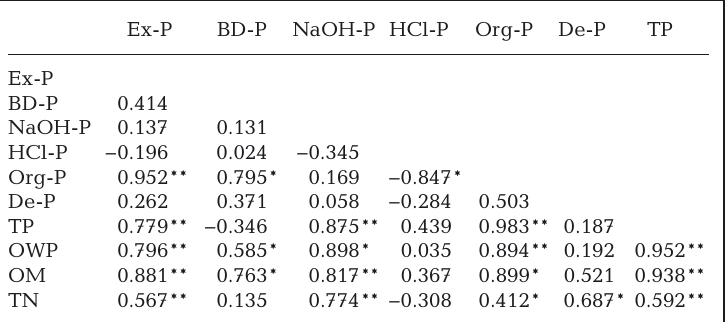
Table 3. Pearson correlation coefficients between the concentrations of different phosphorus (P) fractions, overlying-water phosphate (OWP), or- ganic matter (OM), and total nitrogen (TN). BD-P: redox-sensitive P; De-P: detrital P; Ex-P: exchangeable or loosely sorbed P; HCl-P: calcium-bound P; NaOH-P: metal oxide-bound P; Org-P: organic P; TP: total P. *p < 0.05, **p <